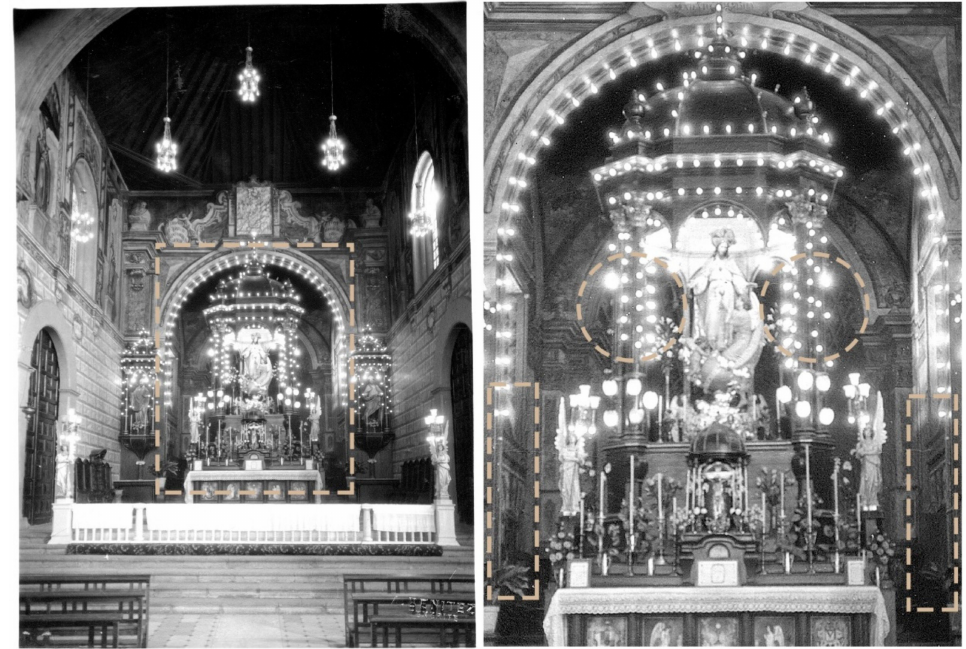
Figure 13. Enlargement and contrast enhancement of the only surviving photographic record showing the second body of the presbytery. This image assisted researchers in better defining the shape of the murals rescued using DStretch. Source: Universidad de Sevilla.